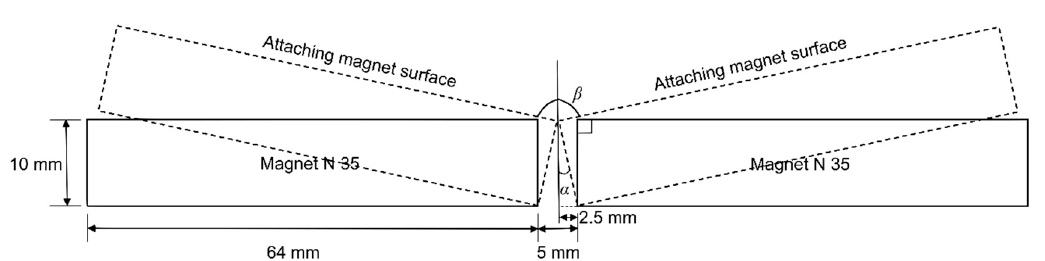
Figure 9. Attachable angle of magnetic liquid stop